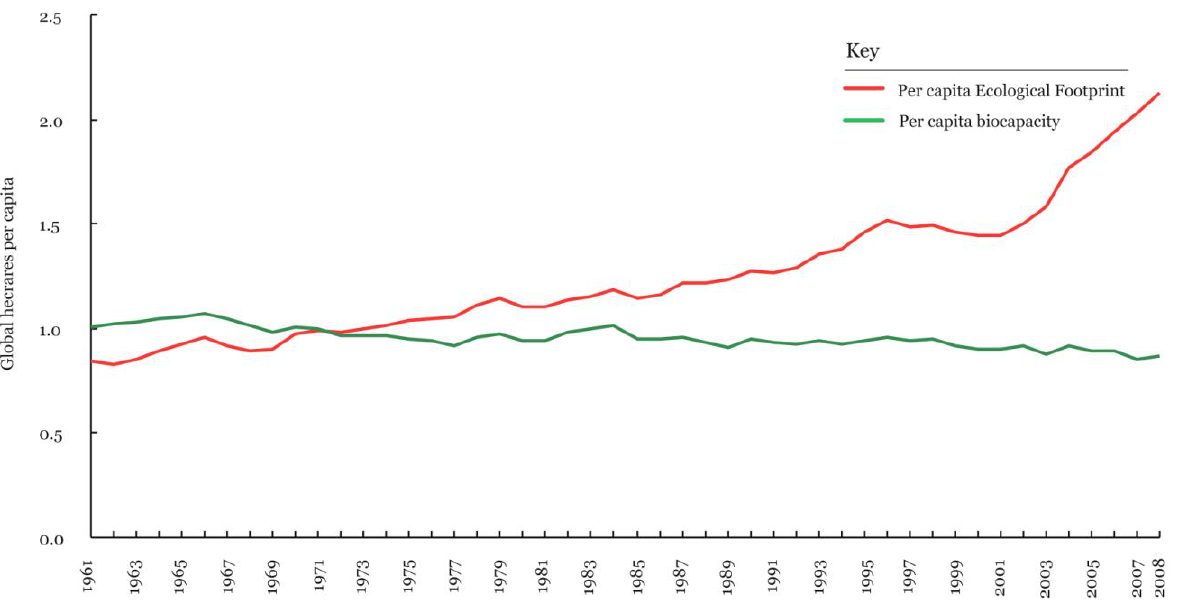
Fig. 11. China's per capita ecological footprint and biocapacity (1961-2008)(Source: Footprintnetwork, 2016)